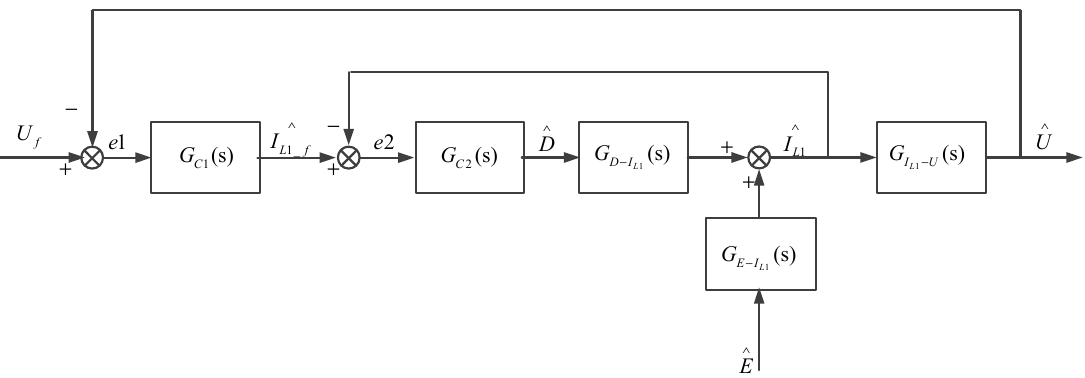
Figure 8. Control block diagram after adding input voltage disturbance.